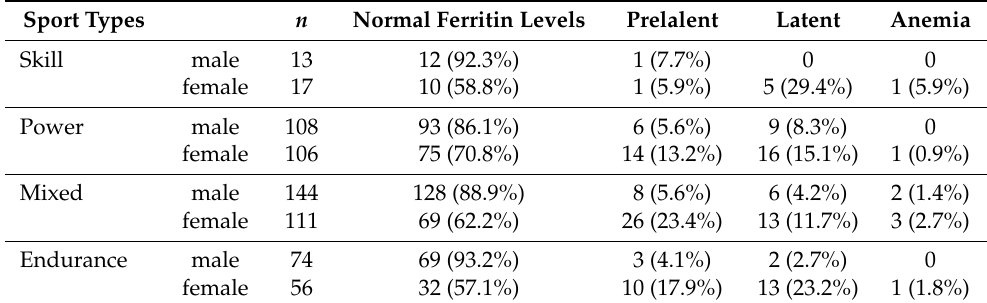
Table 2. Sport type comparison of iron status.